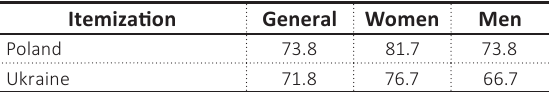
Table 1. Life expectancy in terms of years in Poland and Ukraine